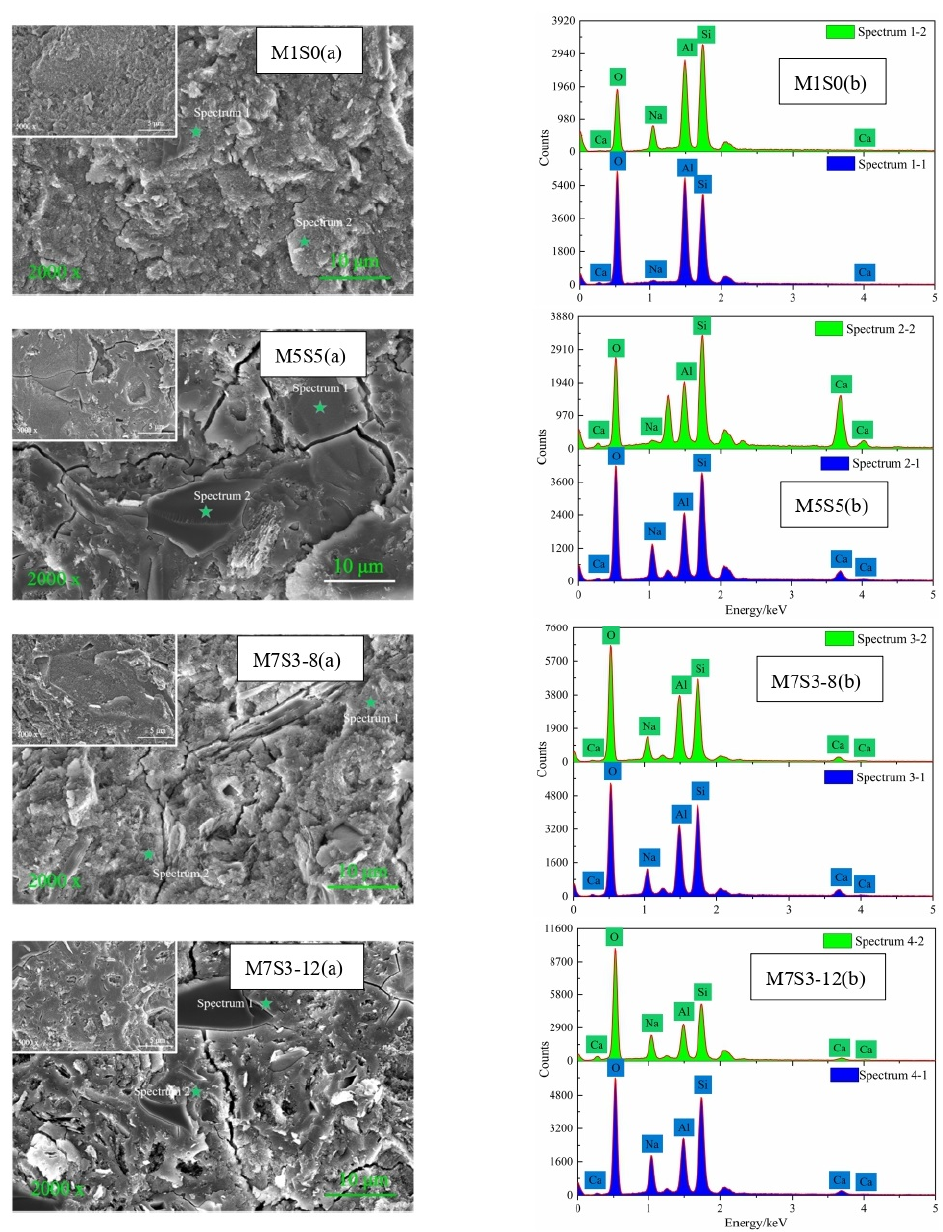
Figure 9. SEM and EDS images of AAMS composite cementitious materials. Images M7S3-8(a) and M7S3-12(a) in Figure 9 indicate that when the Na 2 O content was 8%, there was a large amount of unreacted metakaolin inside the AAMS material, and the structure was loose due to the cracks generated. With an increase in the Na 2 O